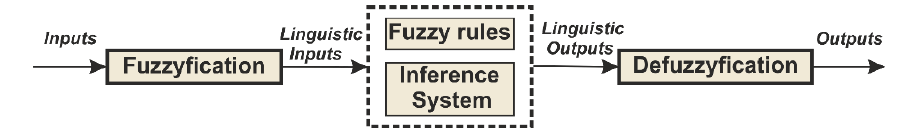
Figure 8. Processing steps of a fuzzy system